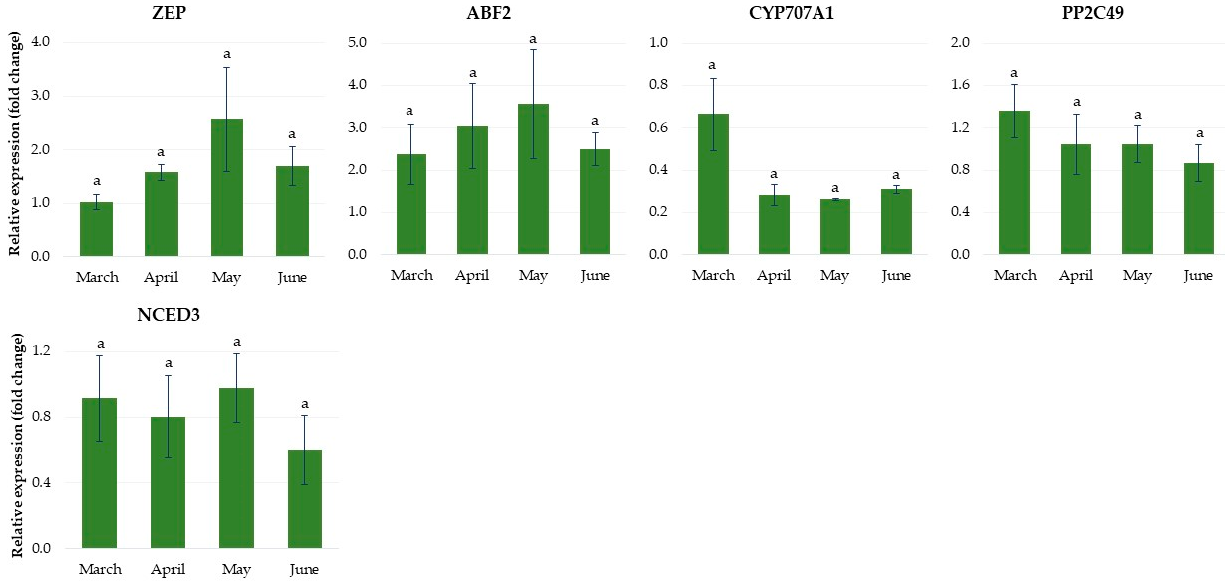
Figure 12. The relative expression of the genes involved in carbohydrate metabolism in rhubarb ‘Raspberry’ plantlets during ex vitro growth in the greenhouse from early March to the end of June. According to Duncan’s test ( p = 0.05), means marked with the same letter do not differ significantly ( p = 0.05). Error bars represent standard deviation.